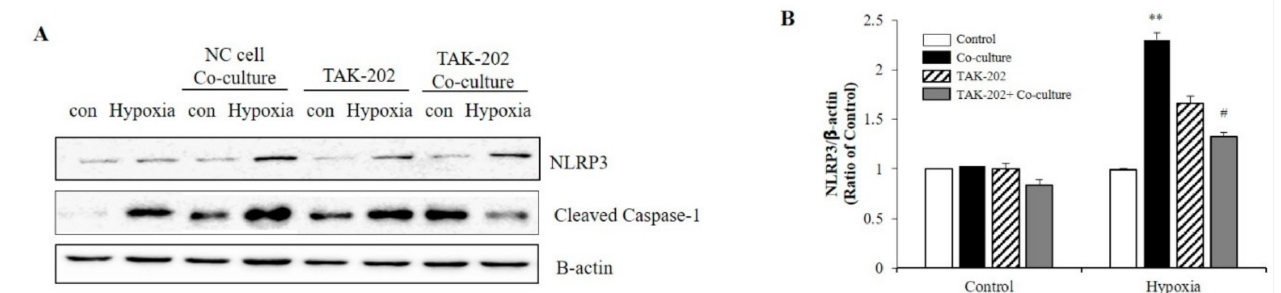
Figure 4. S100A8 derived from neuronal cells induces NLRP3 inflammasome priming in microglia under hypoxic conditions. BV-2 cells were pre-treated with TAK-202 (TLR4 inhibitor, 10 µ g/mL) for 1 h, then stimulated for 48 h in hypoxic condition with SH-SY5Y cells indirectly co-cultured in 0.4 µ m pore transwell. ( A ) The protein expression level was detected by western blotting with NLRP3. β -actin was used as an internal control. ( B ) Quantitative analysis of NLRP3 levels. Data from three independent experiments are presented as the means ± S.D. Values of ** p < 0.01 versus control; # p < 0.05 versus co-cultured sample were considered as statistically